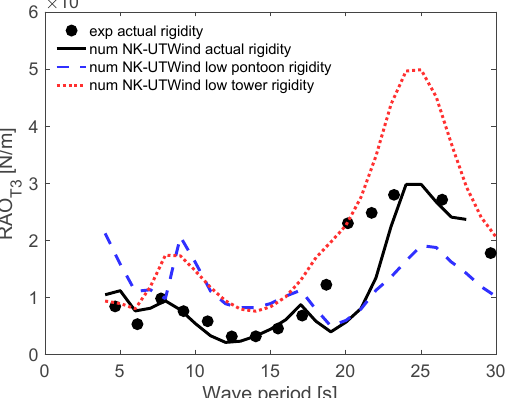
Figure 19. Influence of the tower and pontoon rigidities on the RAO tension result at the side guy wire (T3), and its comparison between the experiment and numerical calculation.